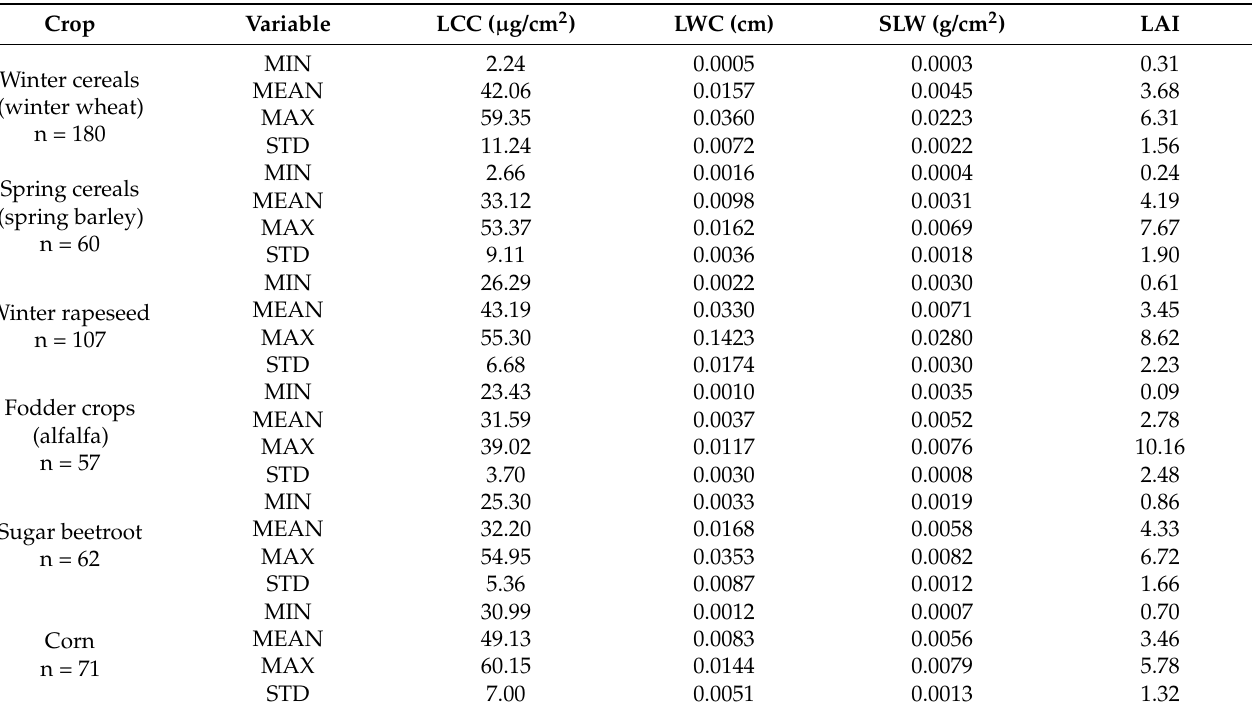
Table 4. Summary of the in-situ measured values of selected biophysical variables (LCC—leaf chlorophyll content, LWC— leaf water content, SLW—specific leaf weight and LAI—leaf area index).